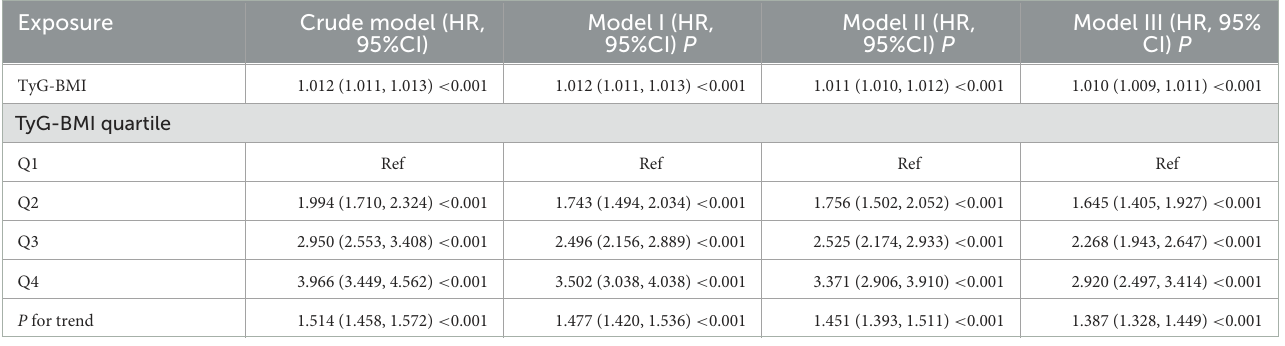
TABLE 4 Relationship between TyG-BMI and the risk of diabetes in prediabetic patients in different models. Exposure